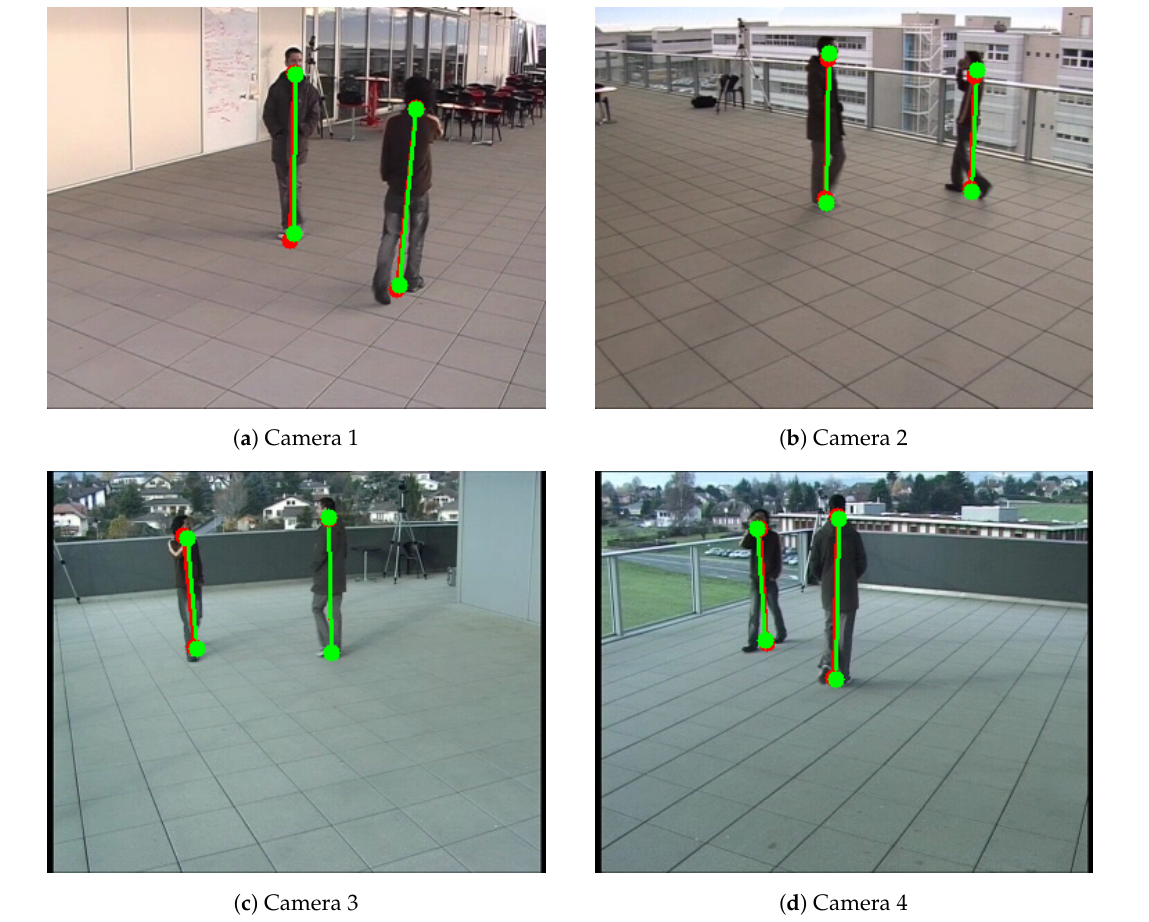
Figure 5. Example of detected the bottom and top positions of the pedestrians of Camera Network 3—EPFL-Terrace dataset [37]. Red color represents detected positions by the human pose estimation method. Green color represents the detected reprojected positions.